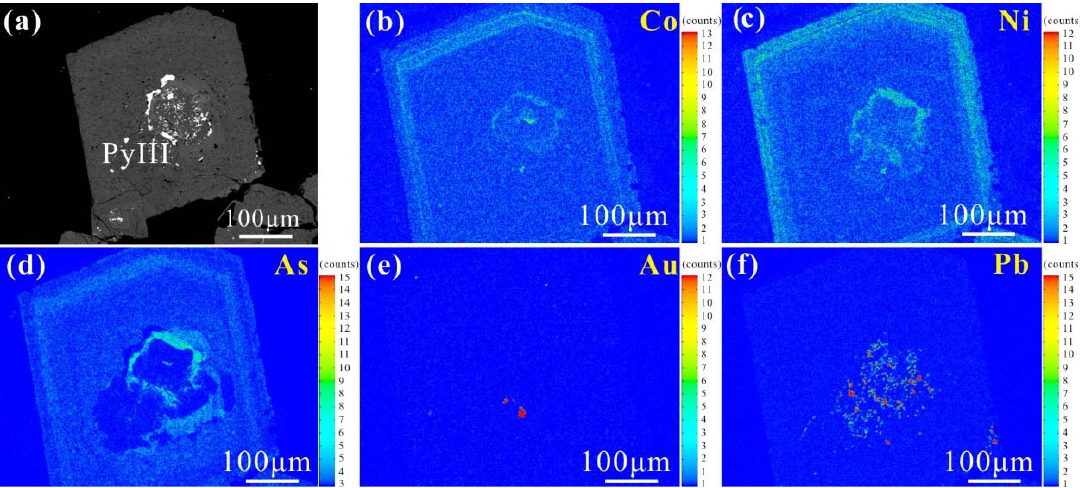
Figure 10. ( a ) Backscattered electron image of PyIII from sample 330-11. ( b – f ) X-ray element distribution maps of Co, Ni, As, Au, and Pb in PyIII. The inclusion-rich PyIII contains inclusions of galena, sphalerite, chalcopyrite, tetrahedrite, pyrrhotite and native gold; the distributions of As, Co, and Ni are heterogeneous in inter; oscillatory zonation is present in outer; and the distributions of Au and Pb are present in inclusions.